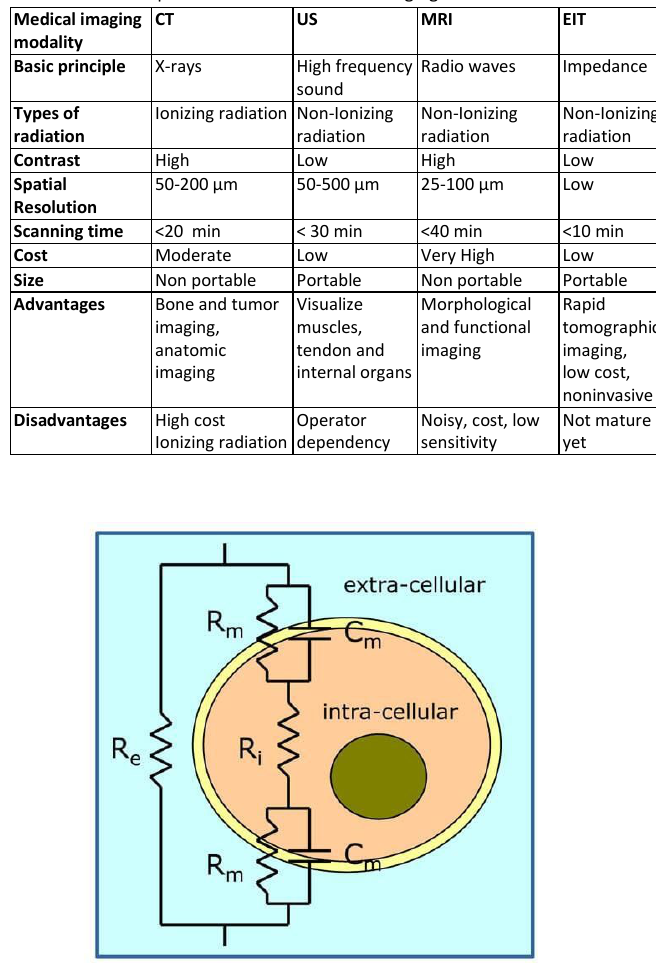
Fig.1: The equivalent electrical circuit model for